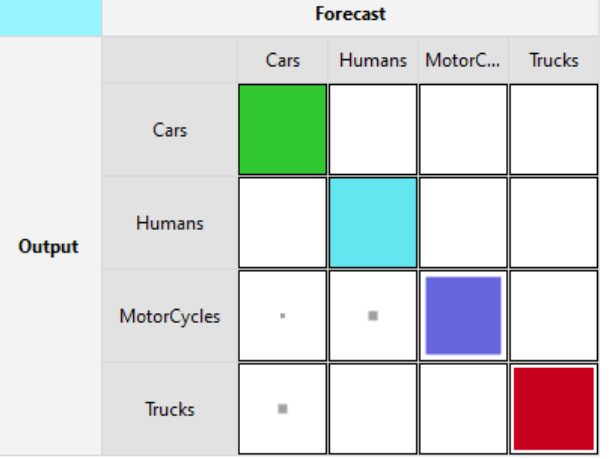
Figure 3. Radar training forecast [3].